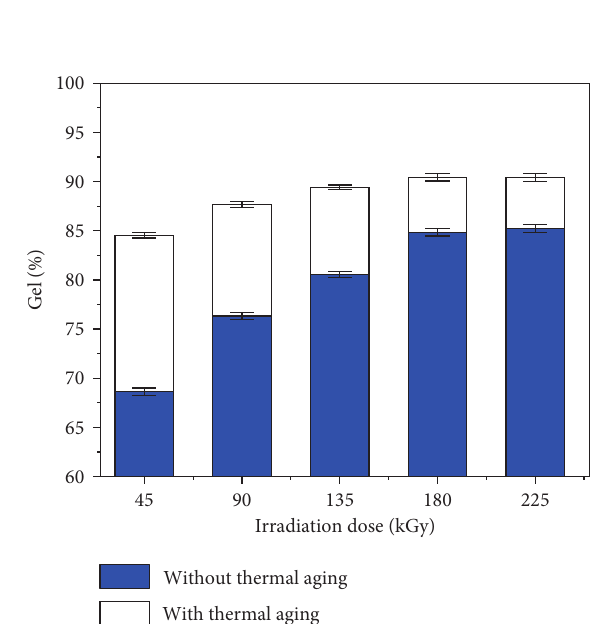
Figure 1: Effects of radiation dose on the gel fraction of BR/NR blends.